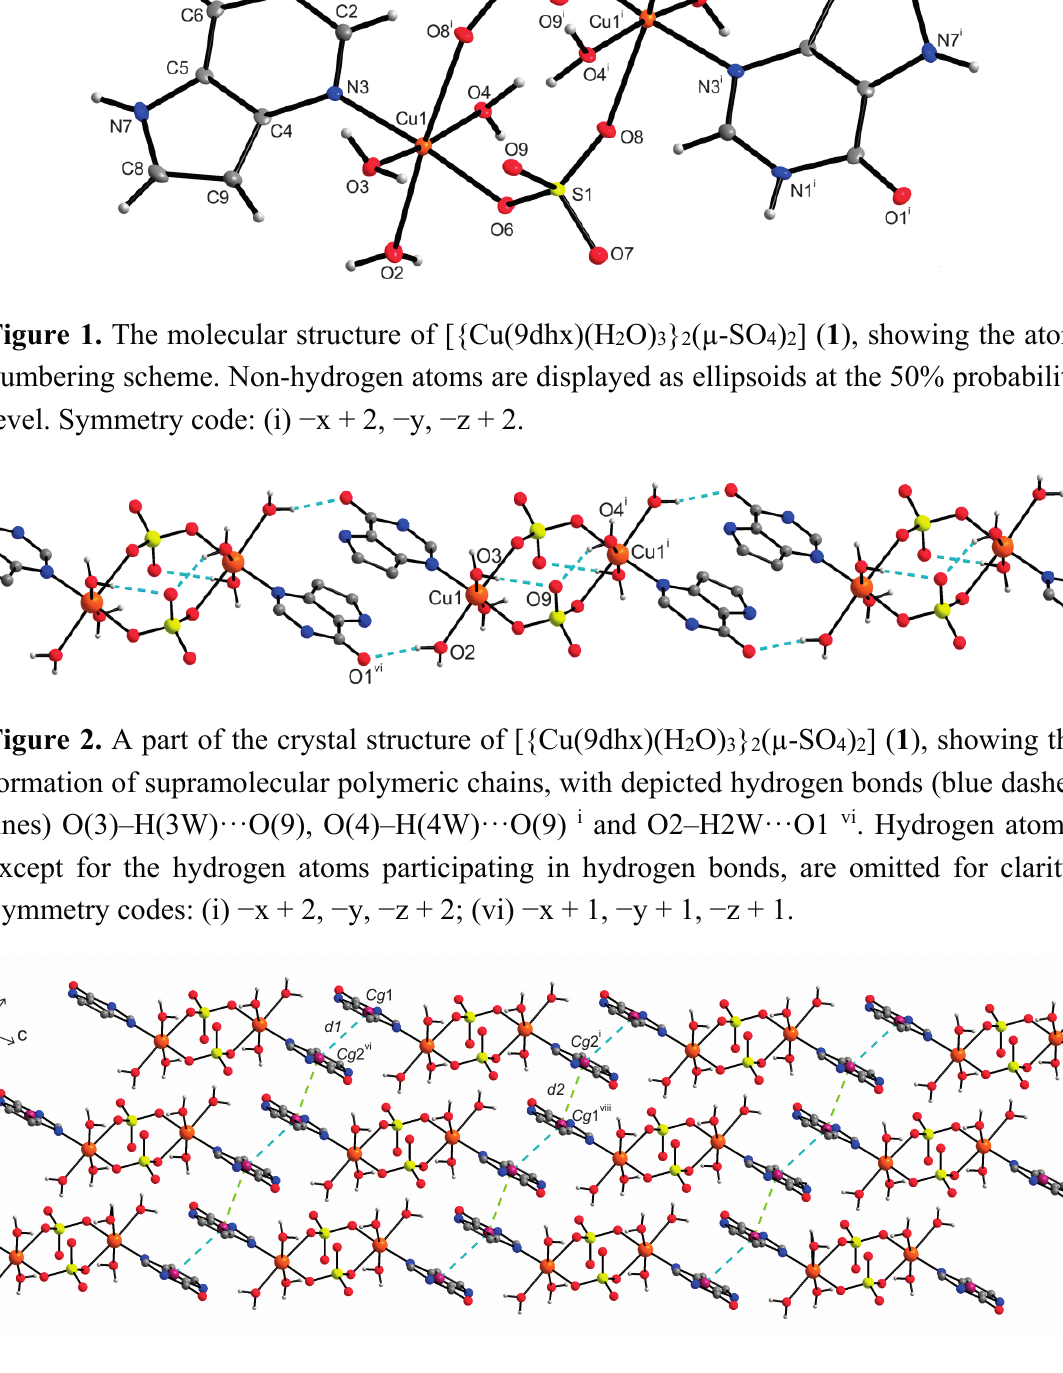
Figure 3. A perspective view of the supramolecular structure of [{Cu(9dhx)(H 2 O) 3 } 2 (µ-SO 4 ) 2 ] ( 1 ), showing the different distances of π ··· π interactions between the centroids of two adjacent and coplanar 9dhx moieties, d1 { Cg 1··· Cg 2 vi } = 3.5277(1) Å (blue dashed lines) and d2 { Cg 2 i ··· Cg 1 viii } = 3.5592(1) Å (green dashed lines). Symmetry codes: (i) − x + 2, − y, − z + 2; (vi) − x + 1, − y + 1, − z + 1; (viii) x, y − 1, z +